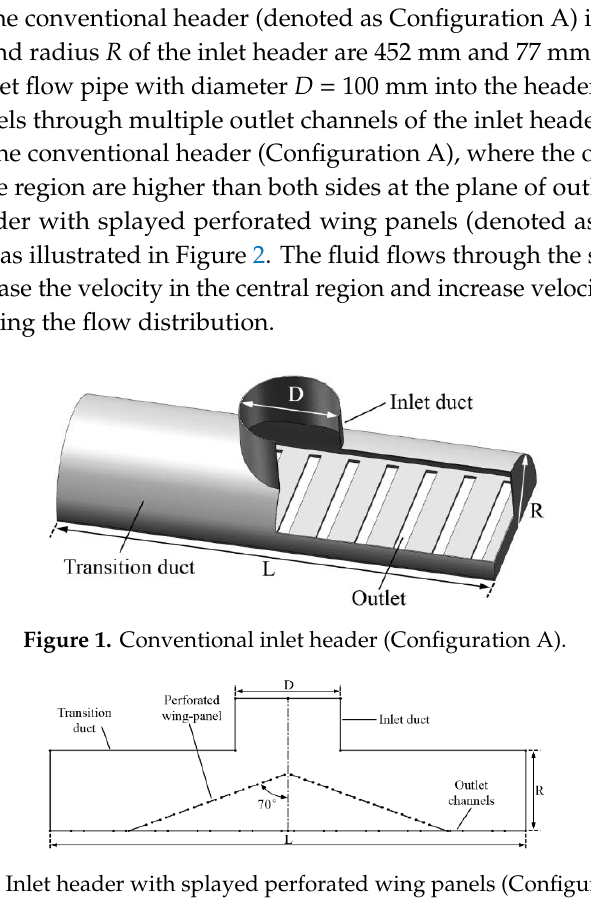
Figure 2. Inlet header with splayed perforated wing panels (Configuration B).